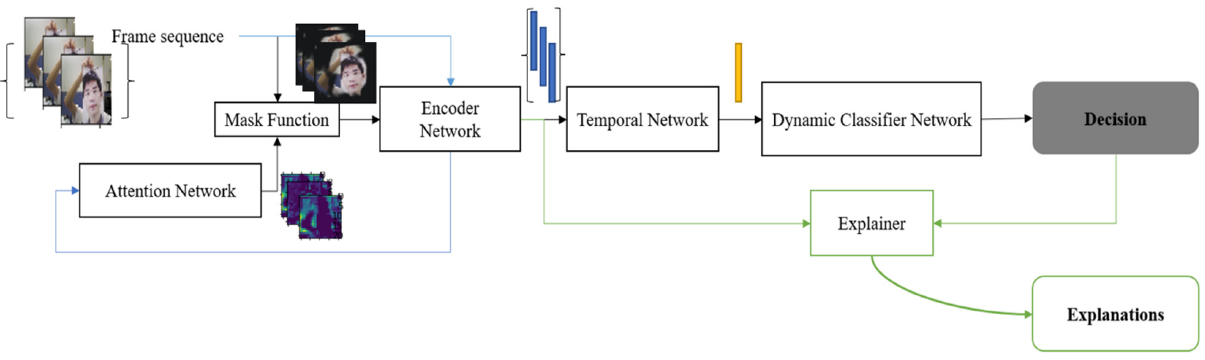
Figure 1. The proposed Dynamic Attention Convolutional Network (DACN). (1) Attention generation (Blue line): Firstly, the frame sequence is fed into the Encoder Network to get the feature representation of each frame. Then the attention maps will be generated by the Attention Network from these original feature representations. (2) Decision generation (Black line): the masked frame, which results from the pixel-wise multiplication of the original frame and the attention mask, is fed into the Encoder Network to get the feature vector for a single frame. Then the Temporal Network is used to encapsulate time-related information. The Dynamic Classifier Network is then used to provide the final decision about the input frame sequence. (3) Explanation generation (Green line): The Explainer function explains current decisions.